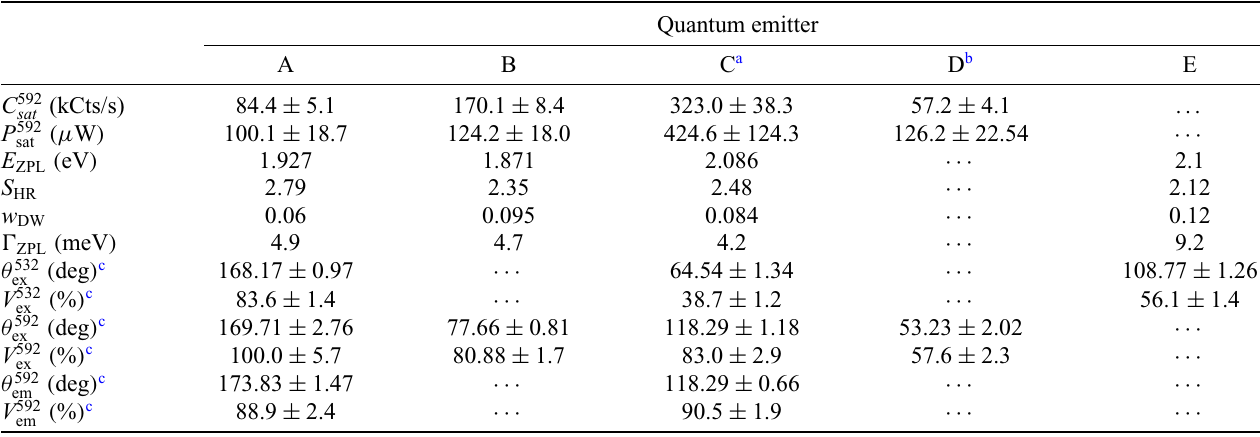
TABLE II. Steady-state PL as a function of power, PL spectra analysis, and optical polarization properties.